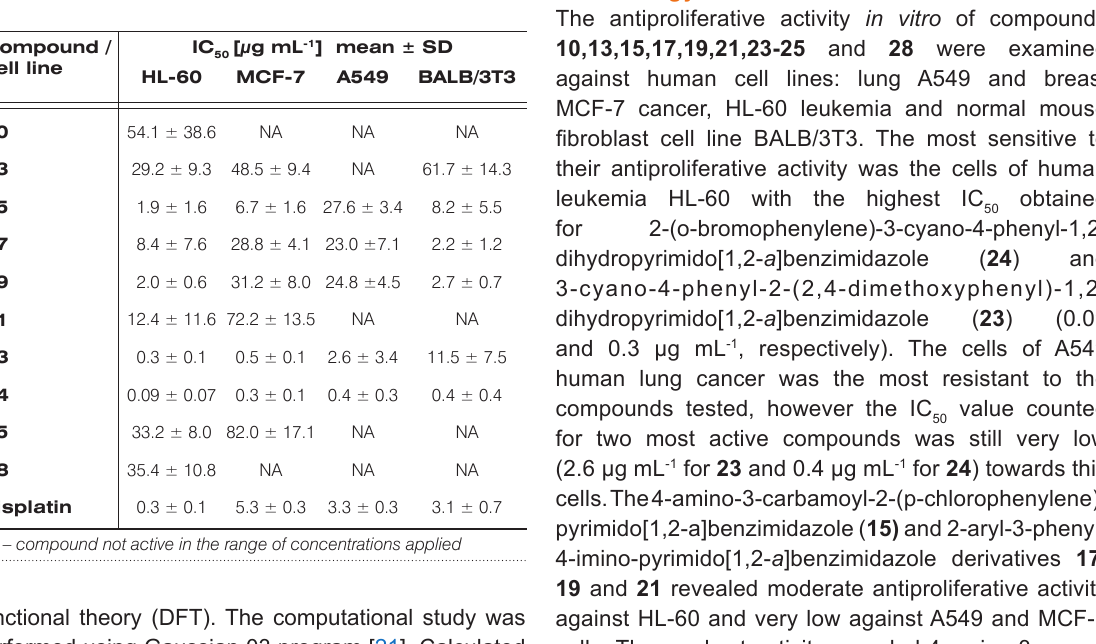
Table 1 . Energy differences ΔE suggested that 10 , 17 and 24 were more probable products than corresponding structures 10a , 17a and 24a respectively.